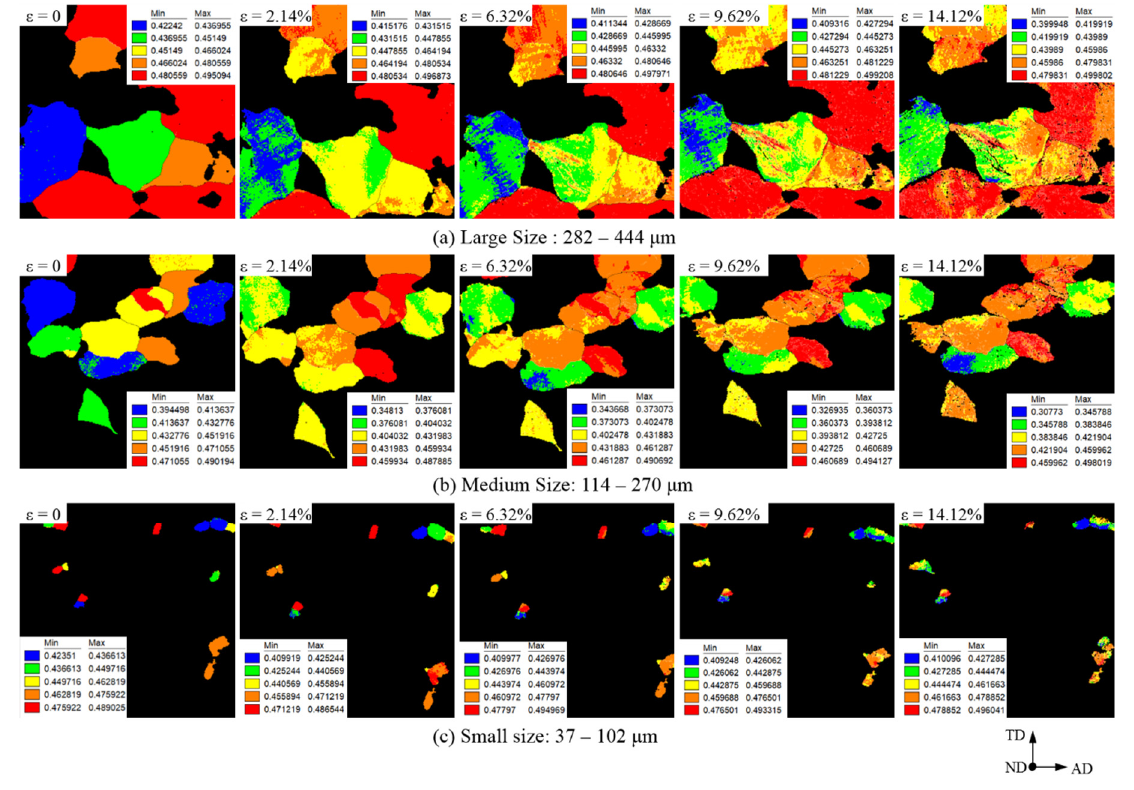
Figure 6. Schmidt factor distribution of the observable field observed by EBSD. To quantitatively characterize the degree of deflection of surface grains of different sizes, the average value of the Schmidt factor for each grain was calculated and shown in Figure 7. The deflection degree of the large ‐ sized grains is the smallest, that of the small ‐ sized grains is medium, and that of the medium ‐ sized grains is the largest. Medium ‐ sized grains, i.e., a grain size of 114–270 μ m, were prone to be deflected during stretching. The Schmidt factor changes toward smaller values until 0.36.